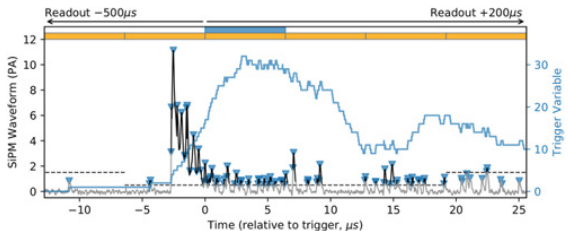
Figure 7. Example neutron waveform (black). The value of the neutron trigger variable (i.e number of peaks in the rolling time window) is shown by the blue